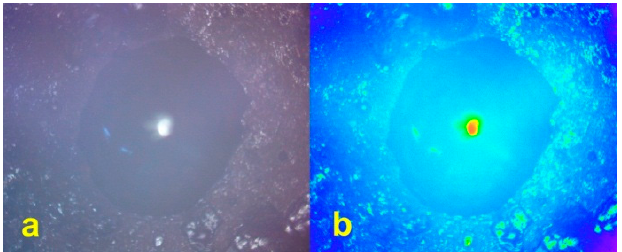
Figure 1. Trial ST3b pellet [16]. Zero valent iron, Fe 0 (ZVI) = 24.9 g/L; Feed Water: 6.52 g Cl − /L + 4.53 g Na + /L; Product water = 2.06 g Cl − /L + 1.29 g Na + /L; Removed: 4.46 g Cl − /L + 3.24 g Na + /L; Feed Water pH = 6.32; Product Water pH = 8.26. ( a ) Reflected light, no filter, showing a central saline water droplet forming due to the presence of hygroscopic, deliquescent, sequestered NaCl. Photograph taken 4 days after the surface was dry cut and polished. White patches are sequestered solid NaCl infilling porosity; ( b ) Reflected light, no filter, converted to a grey scale before false color is applied. The false color analysis clearly shows both the water droplet and the distribution of solid sequestered NaCl (light green). Field of view = 4.5 mm.